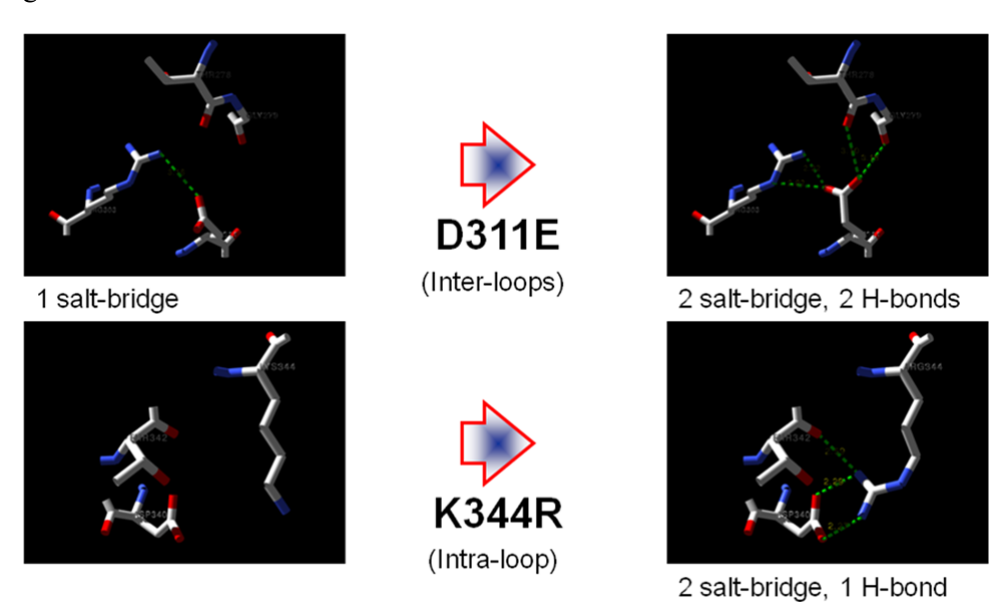
Figure 1. Protein tailoring of D311E lipase forming inter-loops networking, whereby K344R forming intra-loop networking. The green dash line indicated ion pair and hydrogen bond